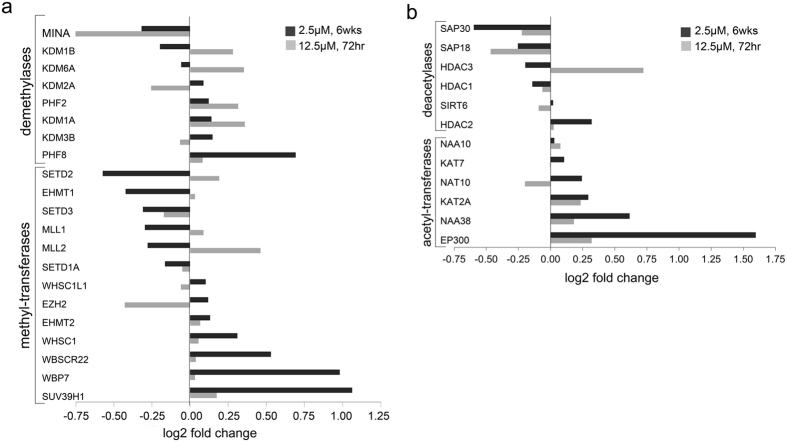
PEITC modulates histone epigenetic regulators in colon cancer cells.(a,b) Modulation of histone methyl transferases and demethylases (a) or acetyltransferases and deacetylases (b) in SW620 cells after short- or long-term exposure to low-dose PEITC. Differential protein binding to either euchromatin or heterochromatin in SW620 cells after 6 weeks or 72 hr PEITC treatment was calculated by log2(PEITC-6wks/CON) or log2(PEITC-72 hr/CON).